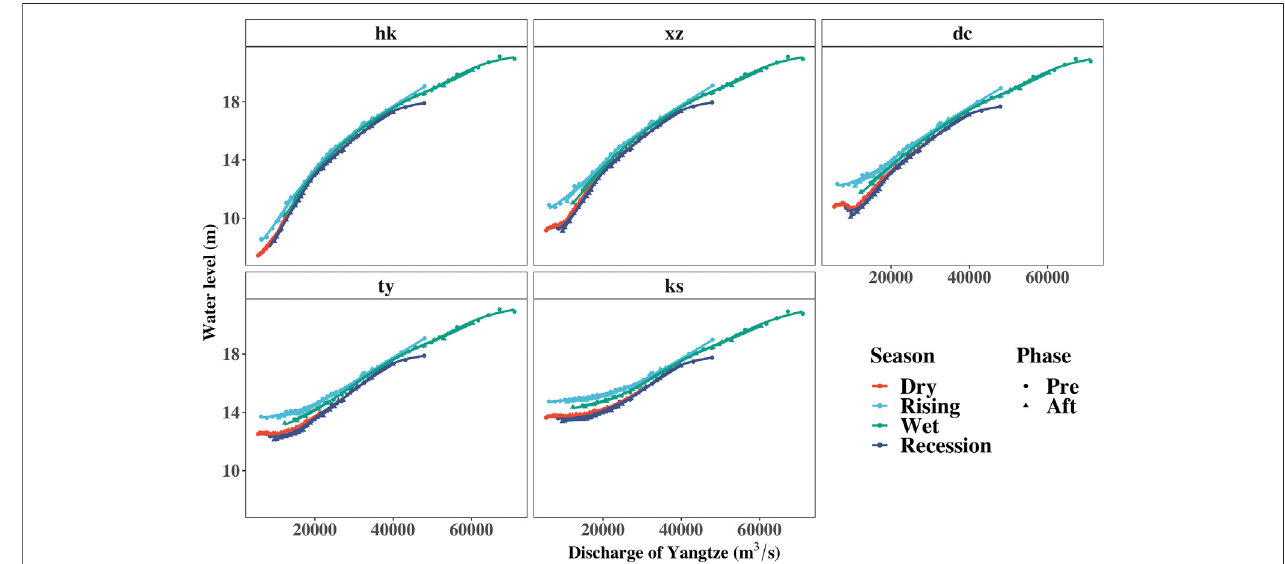
FIGURE 5 | Partial dependence plots of the discharge of the Yangtze River and predicted water level.